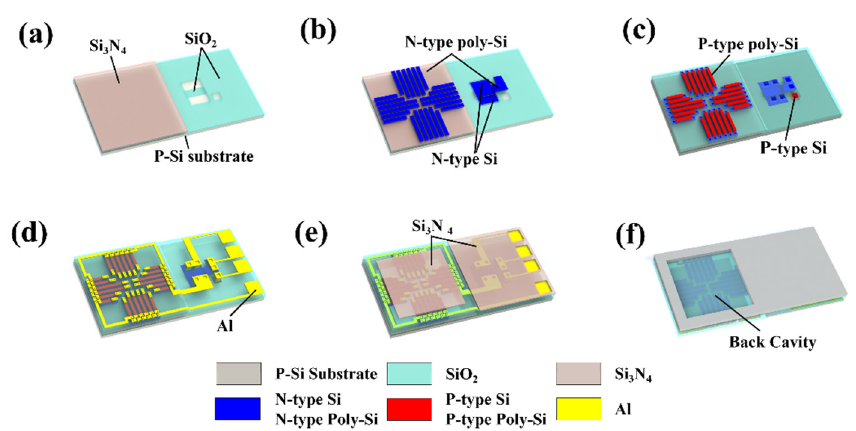
Figure 3. Fabrication processes of TISA pixel monolithically integrated with NMOS. ( a ) Deposition and patterning of silicon oxide and silicon nitride, ( b ) Poly-Si deposition, patterning and phosphorus ions implantation, ( c ) Poly-Si deposition, patterning and boron ions implantation, ( d ) Silicon oxide deposition and Al interconnection, ( e ) Deposition and patterning of silicon oxide, ( f ) Deep silicon releasing at the back-side. Table 1. Role of each process and each mask.